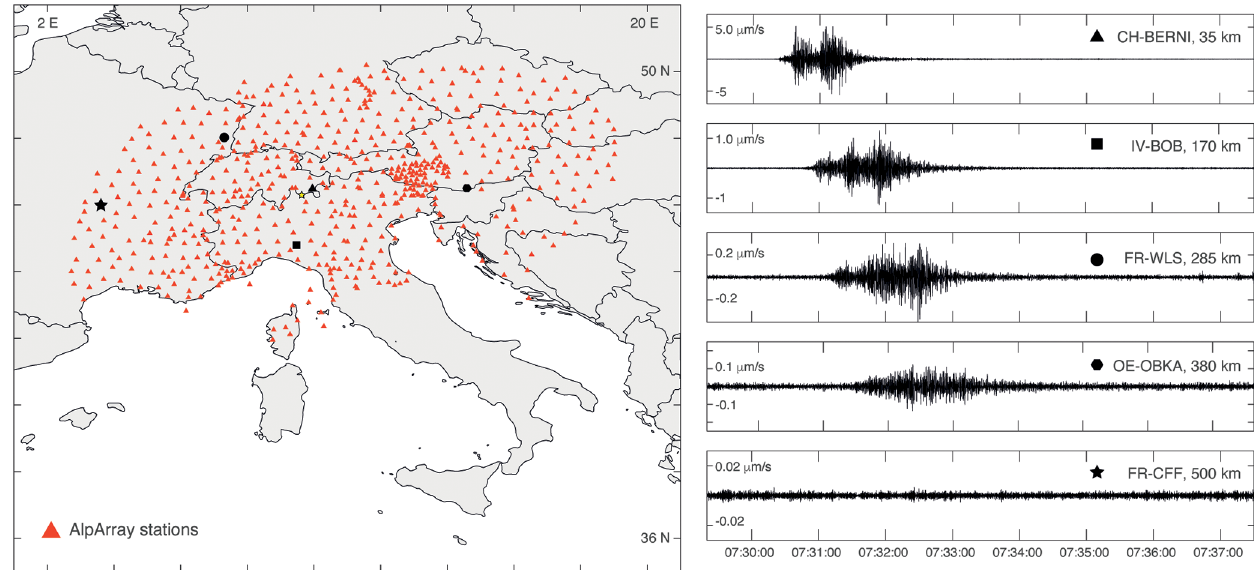
Figure 2. Seismic network and data. The left panel shows the AlpArray network of broadband stations (red triangles). The right panels show the selected signals (vertical component HHZ, where H is high broadband, H is high gain, and Z is vertical orientation) recorded by AlpArray stations located at different distances from event LQ2 (see Table 1), which occurred on 23 August 2017 (i.e., the main Piz Cengalo rock avalanche event; yellow star in the